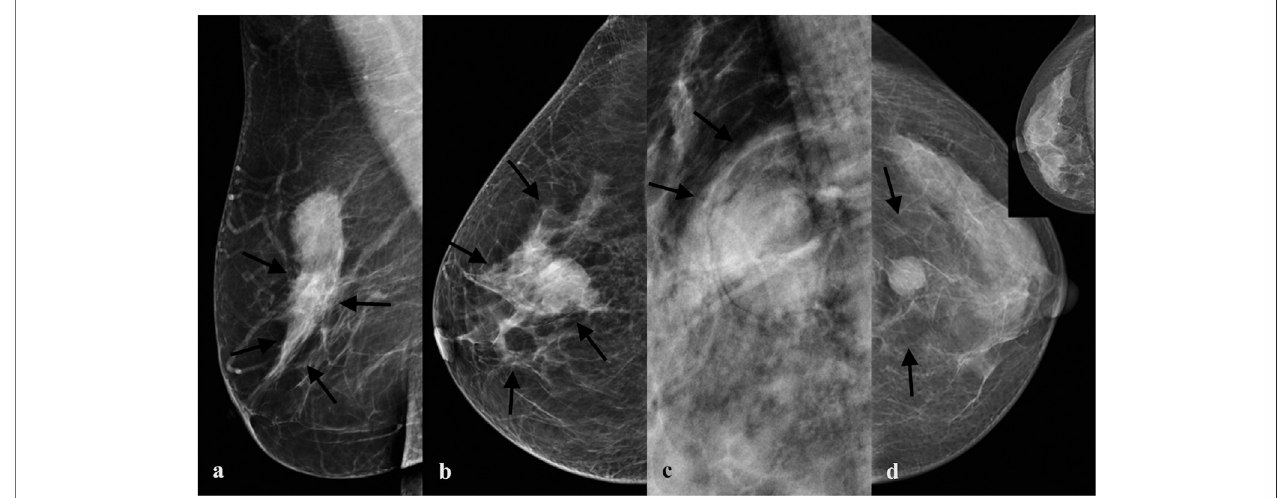
Frontiers in Genetics |